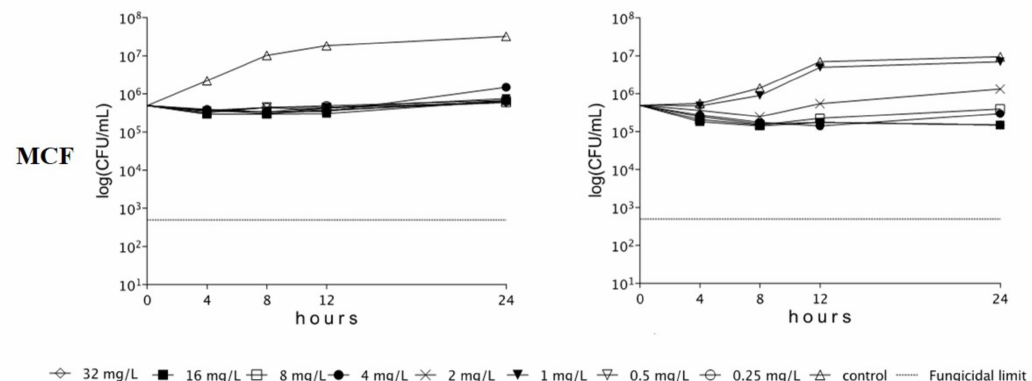
Figure 1. Time-kill plots of rezafungin (RZF), anidulafungin (ANF), caspofungin (CSF), and micafungin (MCF) in RPMI-1640 (RPMI) and RPMI-1640 plus 50% human serum (50% serum) against Candida auris isolate I-172, belonging to the South American clade.